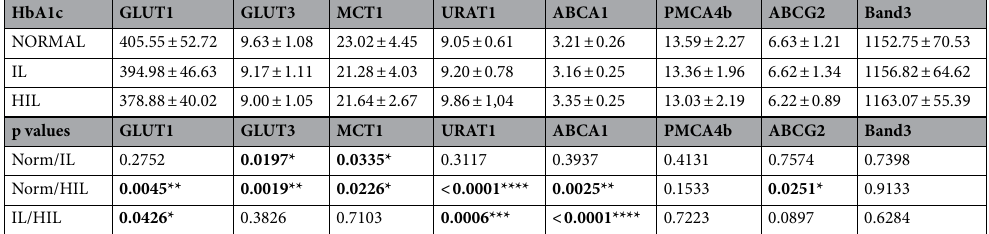
Table 5. Results of Mann–Whitney analysis of membrane protein expression levels in the combined groups of controls and T2DM patients, divided into normal (n = 55, except for MCT1, n = 50), increased level (IL—n = 52, except for MCT1, n = 46) and highly increased level (HIL—n = 64, except for MCT1, n = 59) groups, based on HbA1c levels. The protein expression values are expressed as means ± SD.